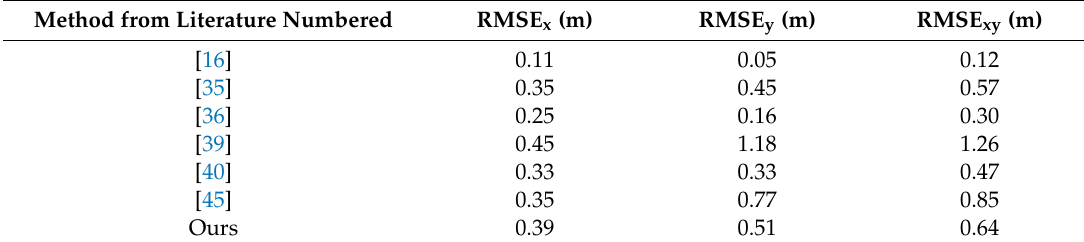
(cid:113) RMSEx 2 + RMSEy 2